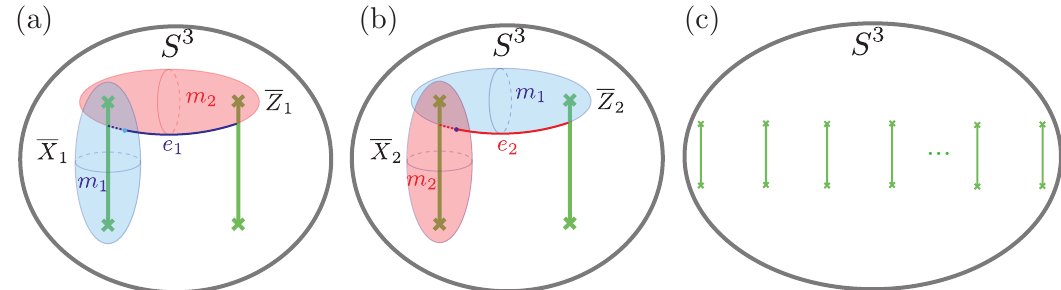
Figure 32: (a,b) The anti-commuting pair of logical operators associated with each of the two logical qubits on a 3-sphere with a pair of open twist strings (4 point = ξ defects). In (a), the logical- X operator X is a Wilson sheet operator (blue) m 1 1 of flux string m supported on a 2-sphere enclosing a twist string. The logical- Z 1 = ξ η operator Z is a product of Wilson sheet operator ξ (red) of flux string m m 2 e 1 m 2 1 2 supported on a 2-sphere encircling two point defects belonging to the two different twist strings and a worldline operator η (blue) of the charge e connecting the two e 1 1 twist strings. The configuration of the logical operators in (b) is the same as those in (a) up to a permutation of the copy label, i.e., 1 ↔ 2. (c) Placing n open twist strings ( n pairs of point defects) on a 3-sphere leads to the ground-state degeneracy 4 n − 1 encoding 2 ( n − 1 ) logical